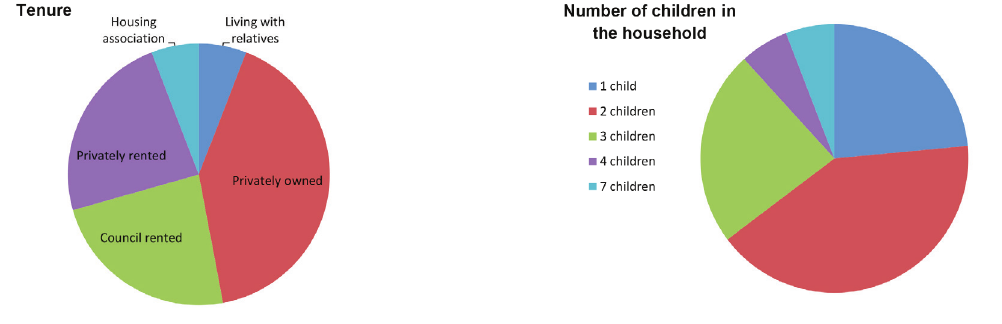
Chart 3: Household interview sample